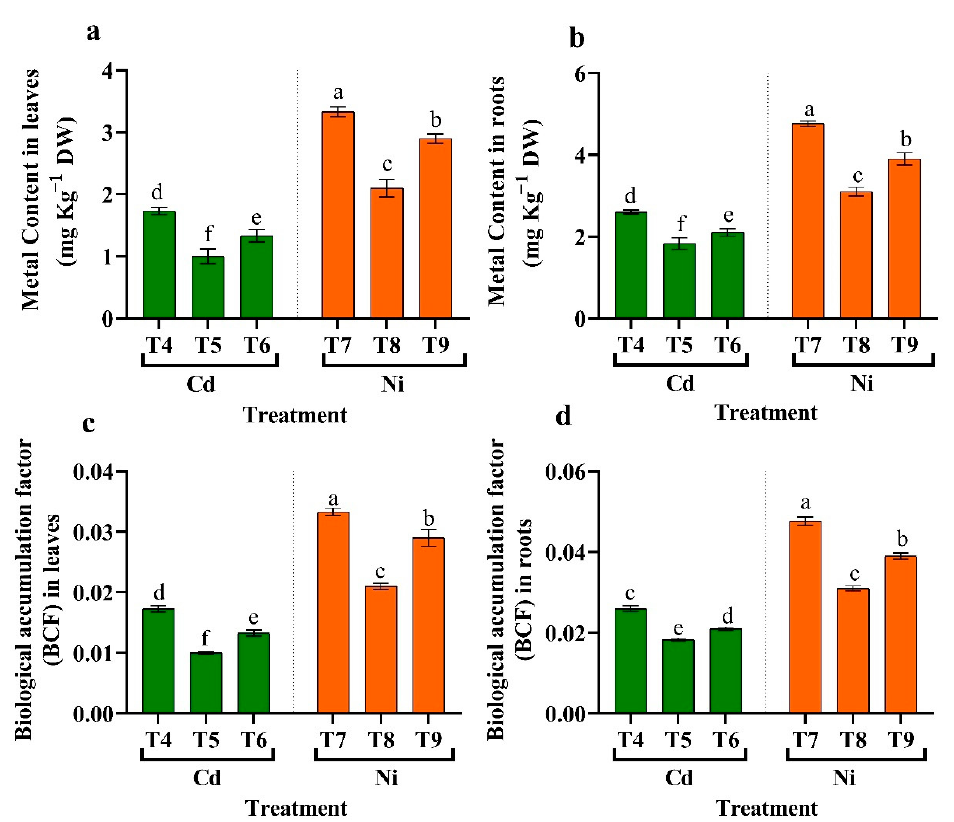
Figure 8. The influence of two endophytic bacteria on Cd, and Ni concentration in ( a ) leaves, ( b ) roots and BCF of Cd and Ni in ( c ) leaves, and ( d ) roots of tomato plants growing under HM stress. test at p < 0.05 reveals significant variations in means ( ± standard error) of different letters (a–f) on Fisher’s test at p < 0.05 reveals significant variations in means (±standard error) of different letters the same bars. T4: 50 µ M Cd, T5: Micrococcus luteus + 50 µ M Cd, T6 : Enterobacter cloacae + 50 µ M Cd (a–f) on the same bars. T4: 50 μ M Cd, T5: Micrococcus luteus + 50 μ M Cd, T6 : Enterobacter cloacae + 50 T7: 50 µ M Ni, T8: Micrococcus luteus + 50 µ M Ni, T9 : Enterobacter cloacae + 50 µ M μ M Cd T7: 50 μ M Ni, T8: Micrococcus luteus + 50 μ M Ni, T9 : Enterobacter cloacae + 50 μ M Ni.